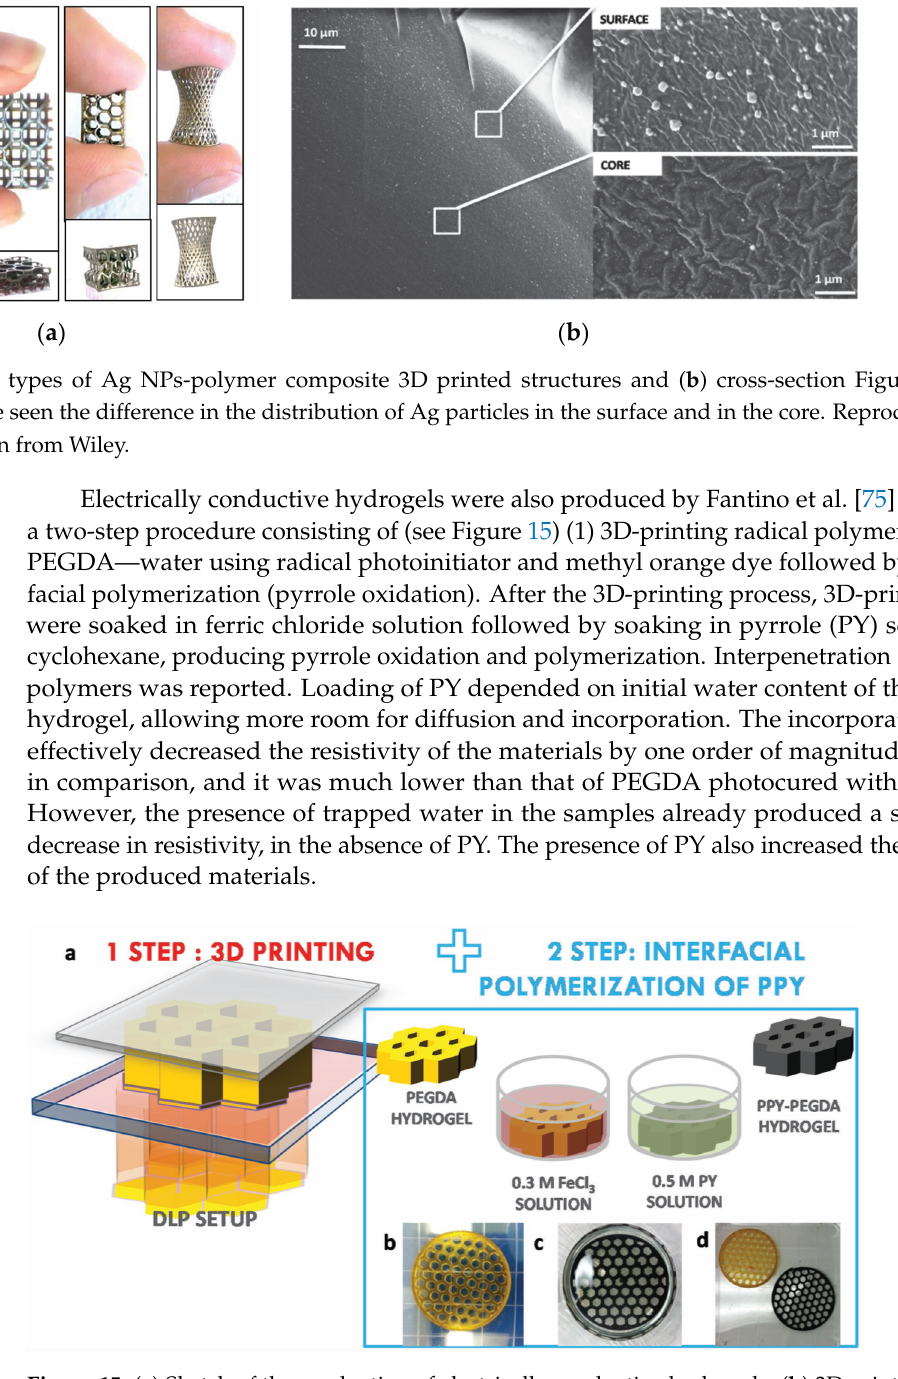
Figure 15. ( a ) Sketch of the production of electrically conductive hydrogels. ( b ) 3D printed PEGDA structure ( c ) PEGDA structure in PY/CYH solution. ( d ) 3D PEGDA and 3D PEGDA/PPY structures. Reproduced from [75] with permission from Wiley.